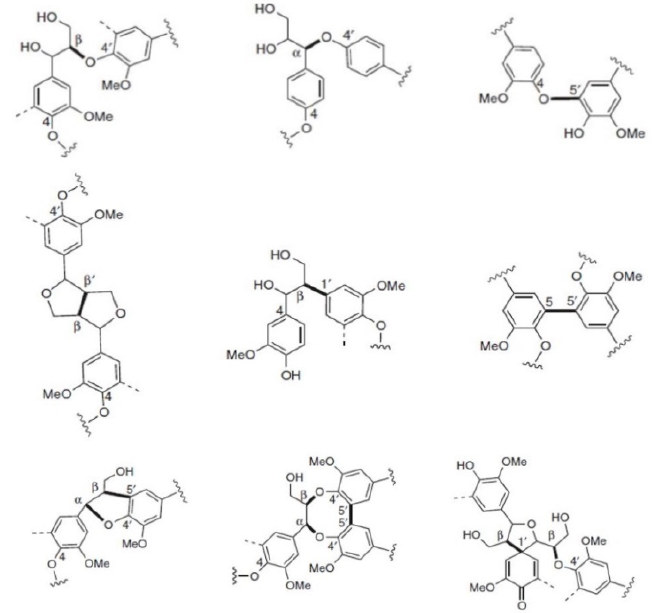
Figure 3. Examples of monolignol linkages. Top : Ether bonds ( β -O-4’, α -O-4’, 4-O-5’); Middle : C–C bonds ( β - β ’, β -1’, 5-5’); Bottom : Complex linkages ( β -5’/ α -O-4’, 5-5’/ β -O-4’/ α -O-4’, β -1’/ β -O-4’). Reprinted from [27] under open access license. Table 1. Abundance of linkages in lignins of soft and hard wood and Miscanthus grasses, including KOH-extractable and non-KOH-extractable, in percentages. Reprinted from [27] under open access